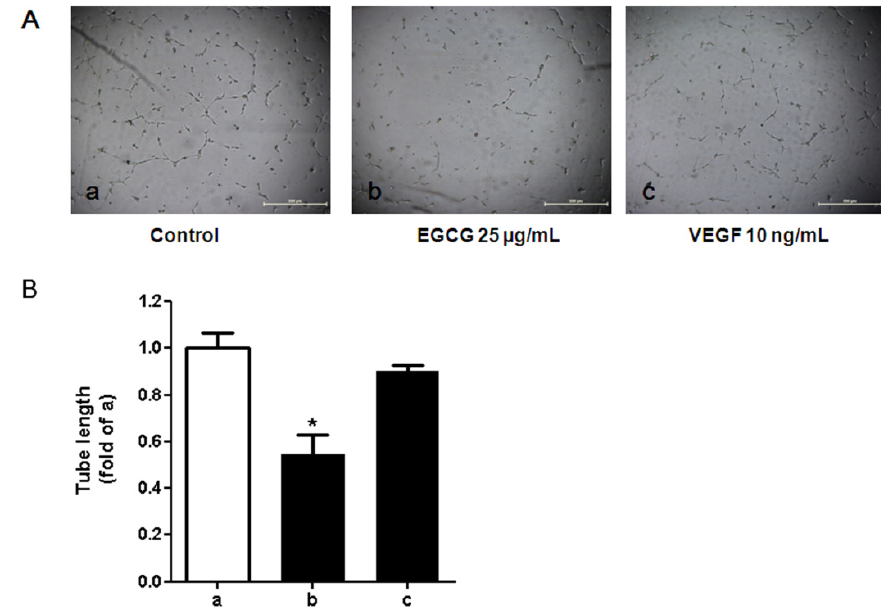
Figure 7. Effects of the conditioned media cultured with 3T3-L1 adipocytes on tube formation activity in human umbilical vein endothelial cells (HUVECs). ( A ) Light microscopic images of HUVEC tube formation in various